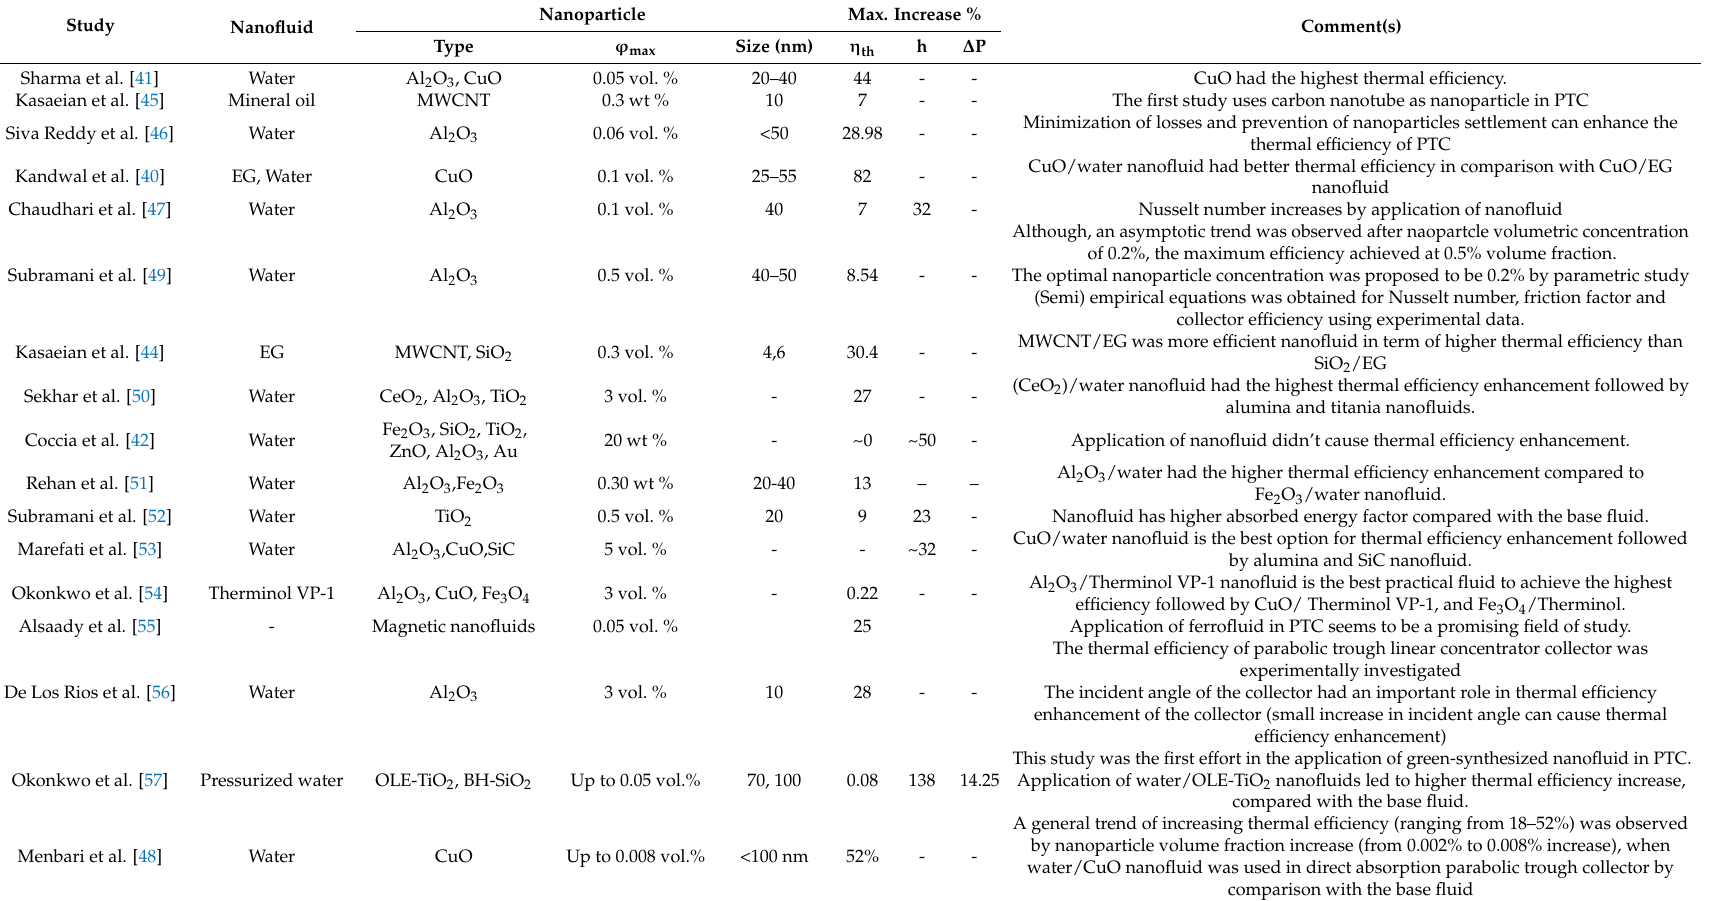
Table A1. Summary of experimental studies conducted on the nanofluid application in